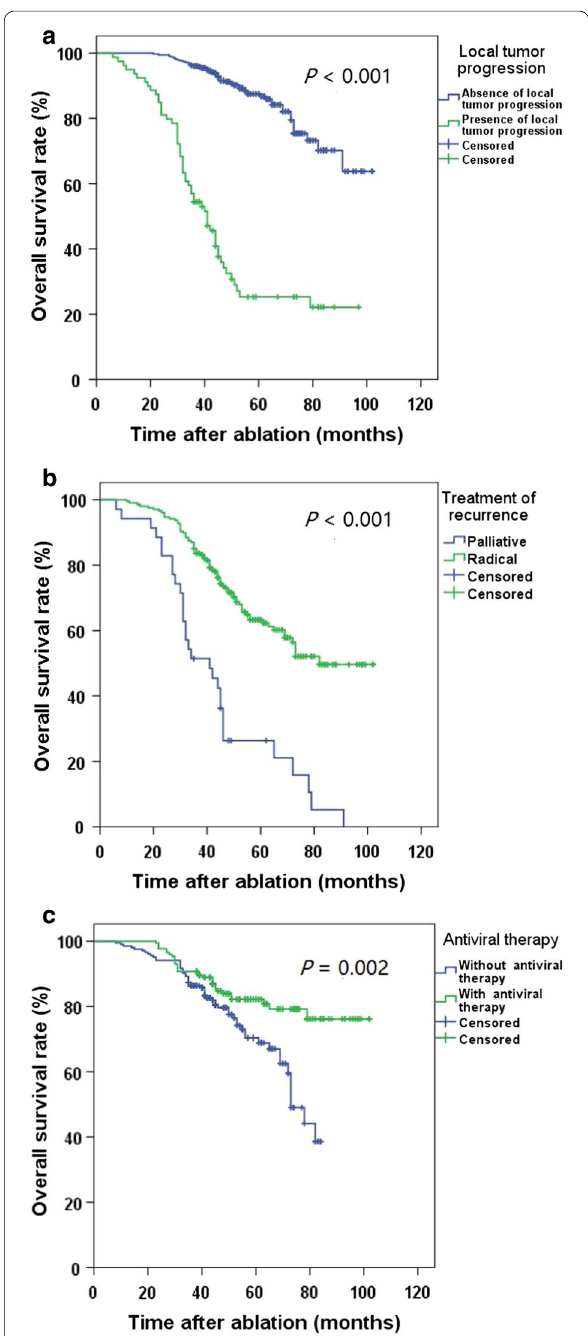
Fig. 3 Overall survival curves for HCC patients in different subgroups. Survivals were evaluated using Kaplan–Meier curves and compared with the log‑rank test. a The overall survival rates of patients without local tumor progression (LTP) are higher than those of patients with LTP ( P < 0.001). b The overall survival rates of patients who received radical therapies are higher than those of patients who received palliative therapies ( P < 0.001). c The overall survival rates of patients who received antiviral therapy are higher than those of patients who did not receive antiviral therapy ( P =